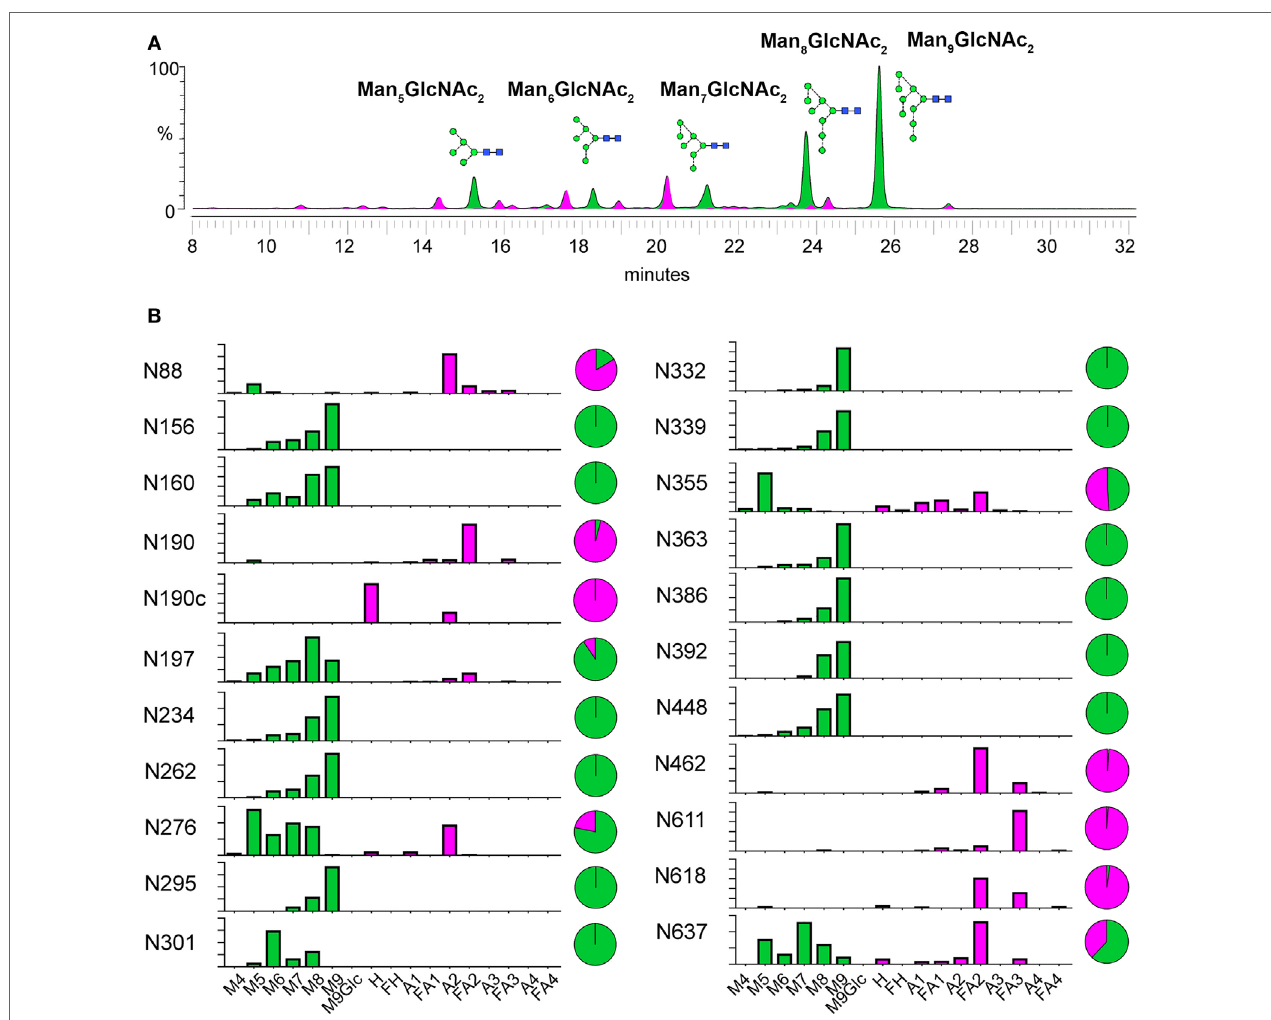
FigUre 3 | Glycosylation analysis of BG505 NFL trimers produced in CHO-M cells. (a) Overall glycan composition. Hydrophilic interaction ultra-performance liquid chromatography spectra of fluorescently labeled N-linked glycans released from BG505 NFL produced in CHO-M cells. Oligomannose- type and hybrid-type glycans are colored green and complex-type glycans are colored pink. The corresponding structure for peaks of oligomannose glycans (Man 5–9 GlcNAc 2 ) are shown and labeled accordingly. (B) Site-specific N-glycosylation analysis. Relative quantification of the microheterogeneity of 22 of 28 BG505 NFL N-glycosylation sites is shown. The trimers were protease digested and analyzed by liquid chromatography–electrospray ionization-tandem mass spectrometry. The bar graphs represent the mean of two analytical replicates and the pie charts display the overall abundance of oligomannose-type (green) and complex- and hybrid-type (magenta) glycans. A sample-specific glycan library used as the basis for this analysis is shown in Table S1 in Supplementary Material. Details of glycopeptide peaks identified are shown in Table S2 in Supplementary Material. Identified glycoforms were grouped according to the number of their antennae. The glycan names are as previously described (43) and as follows: Mn = number (n) of mannose residues; An = number (n) of antennae (e.g., A2 = biantennary); Gn = number (n) of galactose residues; H = hybrid residues; F indicates the presence of a core